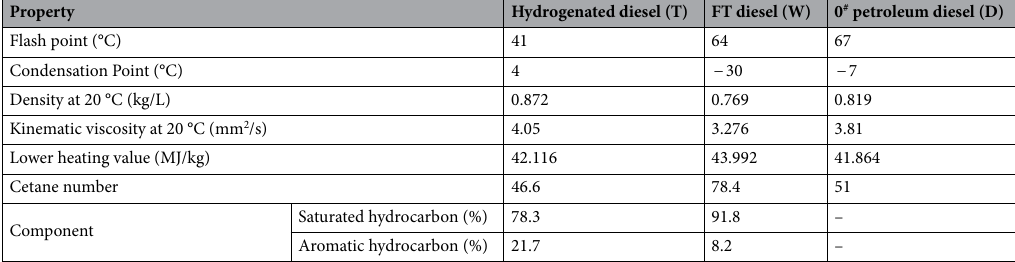
Table 3. Physical and chemical properties of FT diesel, hydrogenated diesel, and 0 # petroleum diesel.